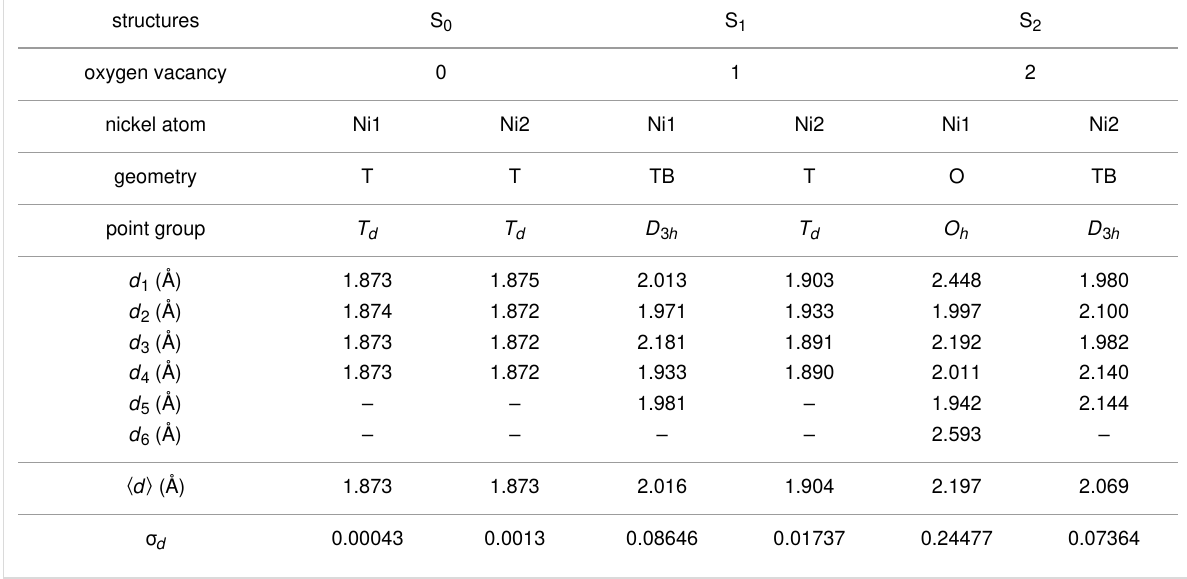
Table 1: Ni–O bond lengths ( d i , i = 1, 2, 3, 4, 5, 6) for nickel atoms Ni1 and Ni2 in the structures S 0 , S 1 , and S 2 containing zero, one, and two oxygen vacancies, respectively. Ni1 and Ni2 are in tetrahedral (T), trigonal bipyramidal (TB), and octahedral (O) geometries. σ d is the standard deviation of Ni–O bond lengths for Ni1 and Ni2 within different geometries. The standard deviation increases with increasing number of oxygen vacancies, indicat- ing how distorted the geometry